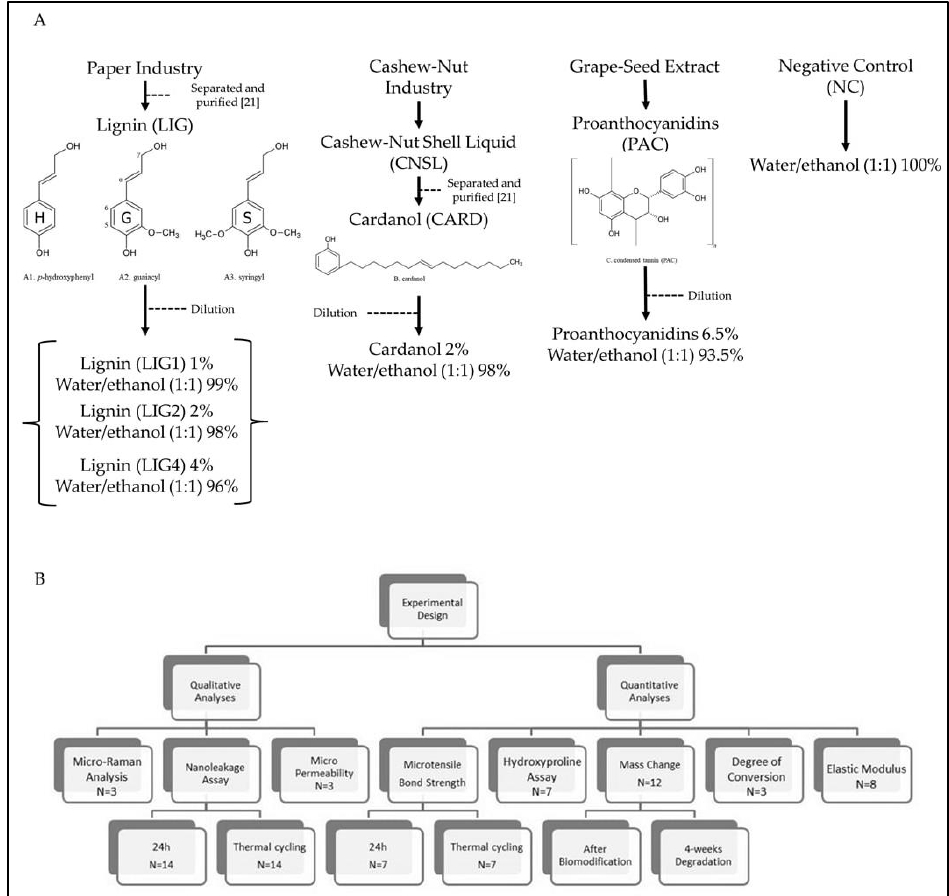
Figure 1. ( A ) Chemical structures of biomodification agents surveyed and steps diagram to the preparation of biomodification solutions [21]. A. Mono-lignol precursors of structural units forming the polymeric lignin molecule; B. Chemical structure of purified cardanol; C. Major structure of proanthocyanidins (PAC) from grape seed extract. ( B ) Diagram of experimental design with all experiments and number of